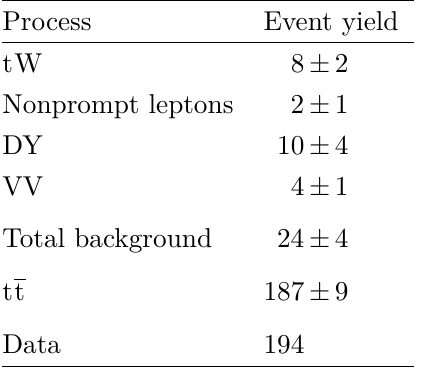
Table 3 . Event yields for all the processes at the final level of selection. The uncertainty corresponds to the quadratic sum of the statistical and systematic